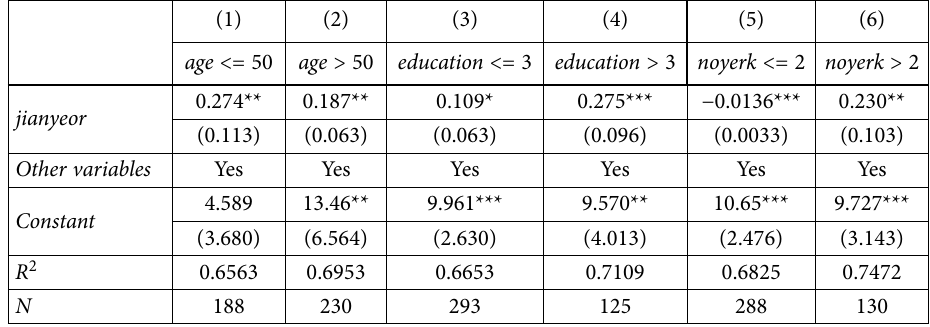
Table 6. Grouping heterogeneity regression results of different influence